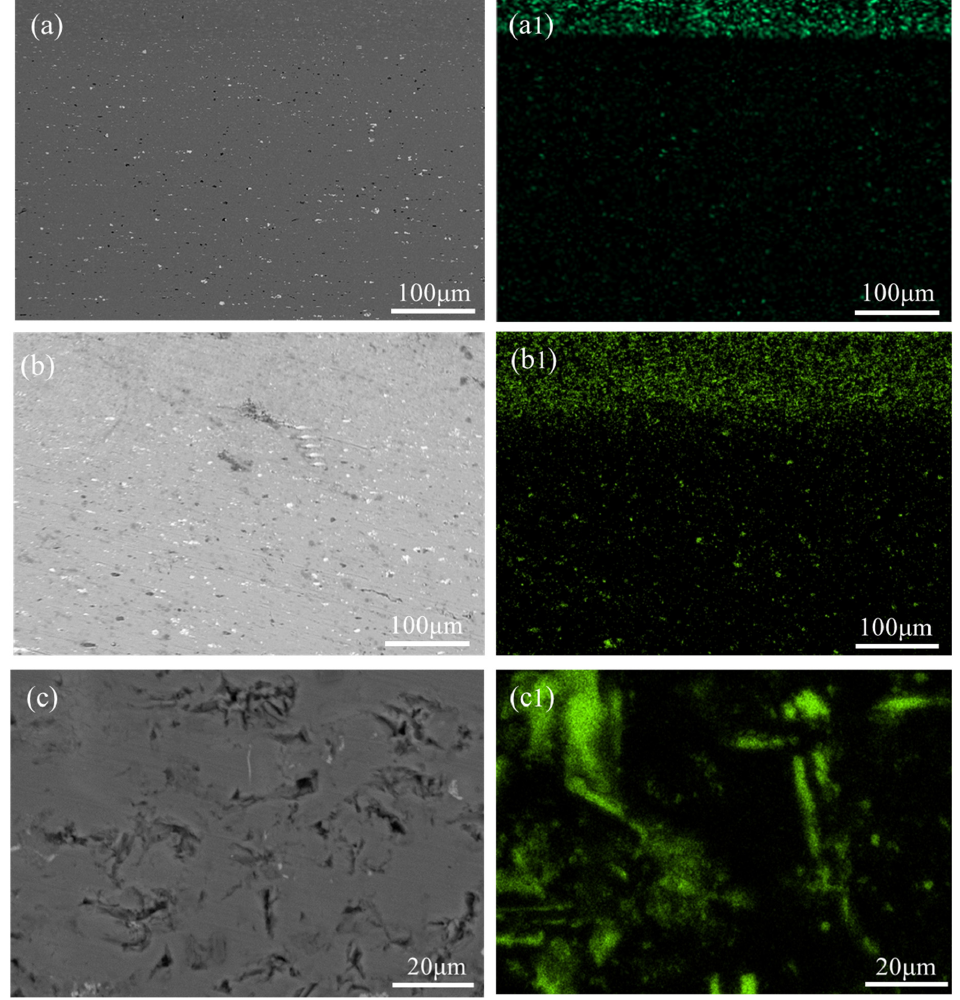
Figure 13. SEM image and the energy dispersive spectroscope (EDS) map of Si for 4343/3003/6111/3003 Al clad sheet in different conditions: ( a , a1 ) cold-rolled state; ( b , b1 ) 330 °C/3 h (annealed state); ( c , c1 ) 330 °C/3 h +610 °C/10 min (brazed